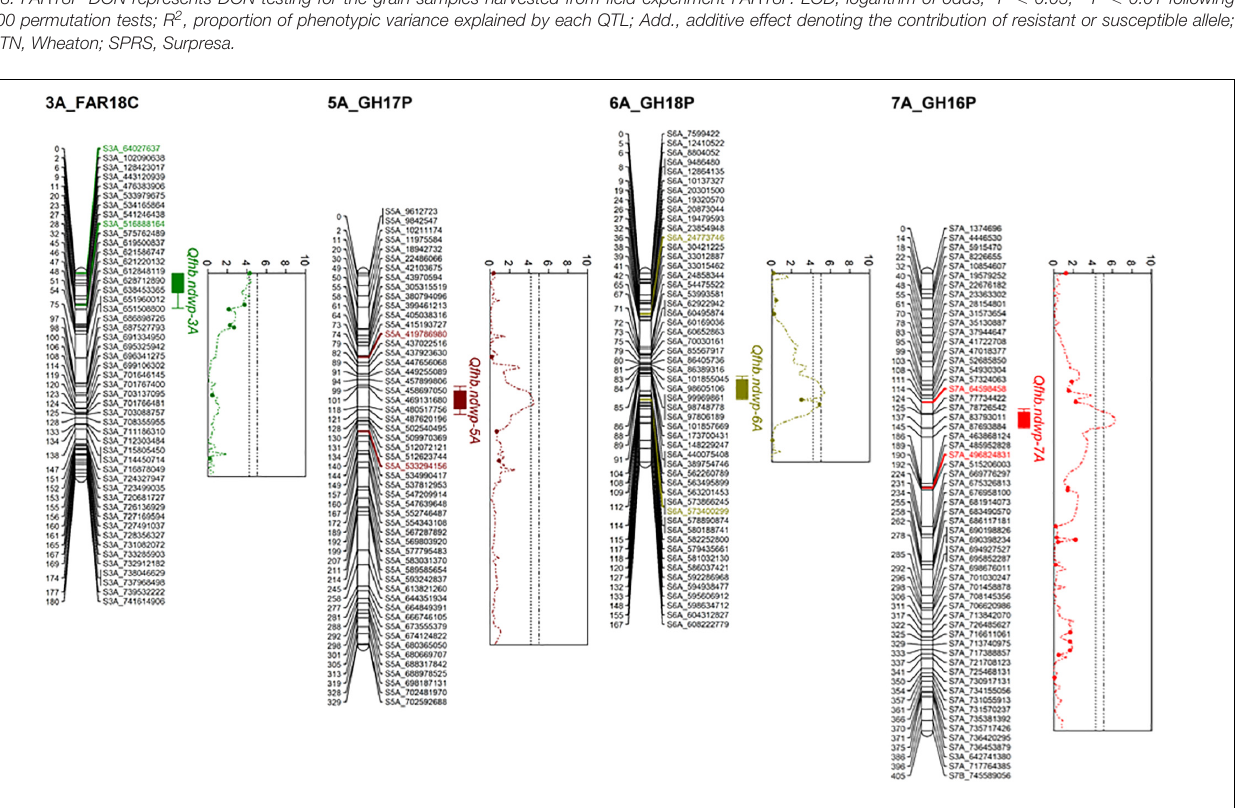
FIGURE 4 | Linkage maps for chromosomes 3A, 5A, 6A, and 7A showing the respective QTL for type II FHB resistance detected in the Wheaton/Surpresa RIL population. The positions of marker loci are shown on the right and the centimorgan (cM) distances between the loci are shown on the left of the linkage